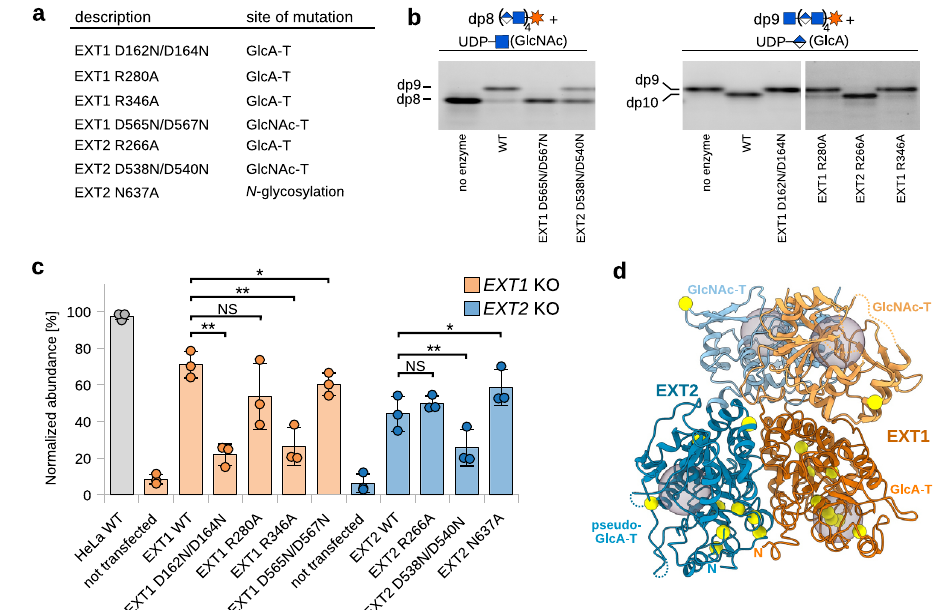
Fig.4|Invitroand incellulo mutationalanalysis.a TablesummarizingEXT1and EXT2mutantsusedinthisstudy. b Invitroactivityassayusing fl uorescently-labeled octa-(dp8)andnona-(dp9)oligosaccharideacceptorsubstratesandpuri fi edEXT1- EXT2complexesharboringeitherEXT1andEXT2wild-typeproteins(WT)oramino acid substitutions in one of the two proteins. Source data is provided as a Source Data 5. c Quanti fi cation of cell surface heparan sulfate levels by fl ow cytometry experiments in HeLa knock-out (KO) cell lines lacking either the EXT1 or EXT2 protein.Theknock-outcelllineswerenottransfectedorcomplementedwitheither WT EXT1 or EXT2 proteins or amino acid substituted versions thereof. Quanti fi ed heparan sulfate content from three independent experiments was normalized to the EXT expression level (see Supplementary Fig. 10) and blotted as percentage